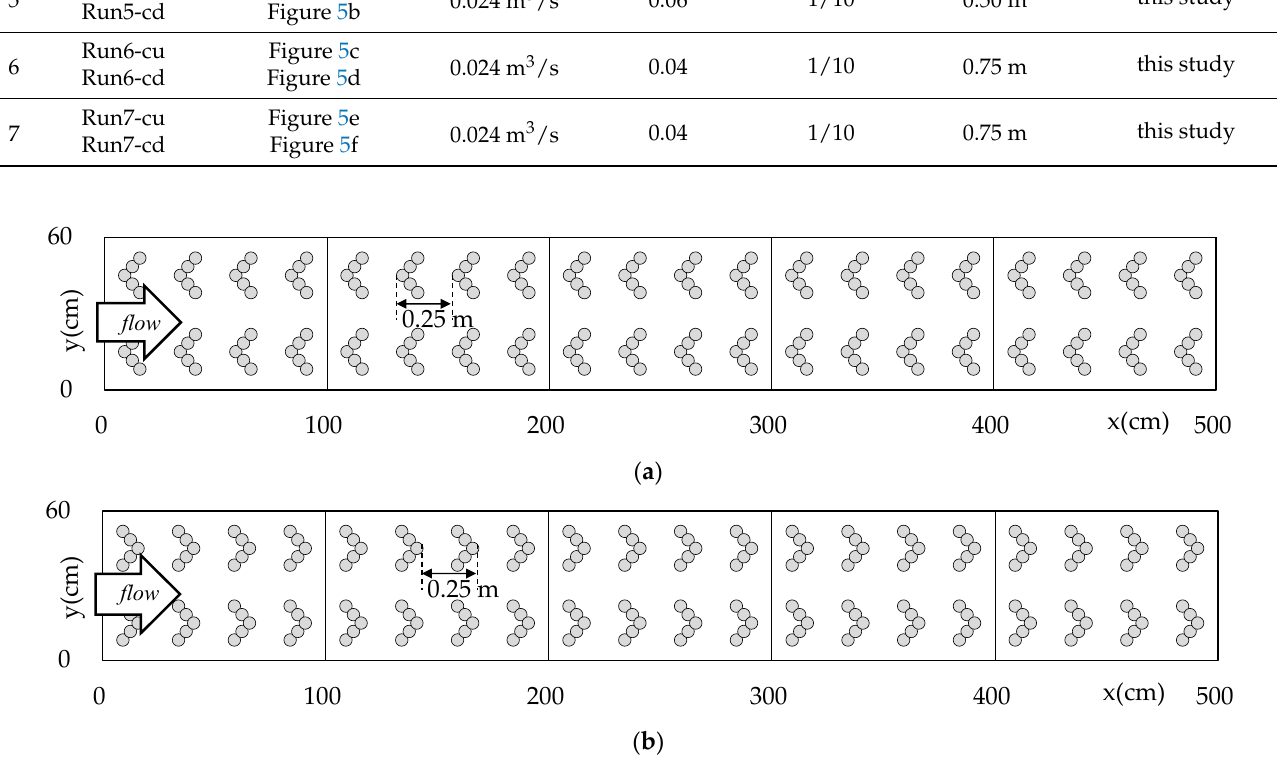
Figure 4. Arrangement of roughness groups in each case of the previous study [4]: ( a ) Run4-cu in Case 4; ( b ) Run4-cd in Case 4.